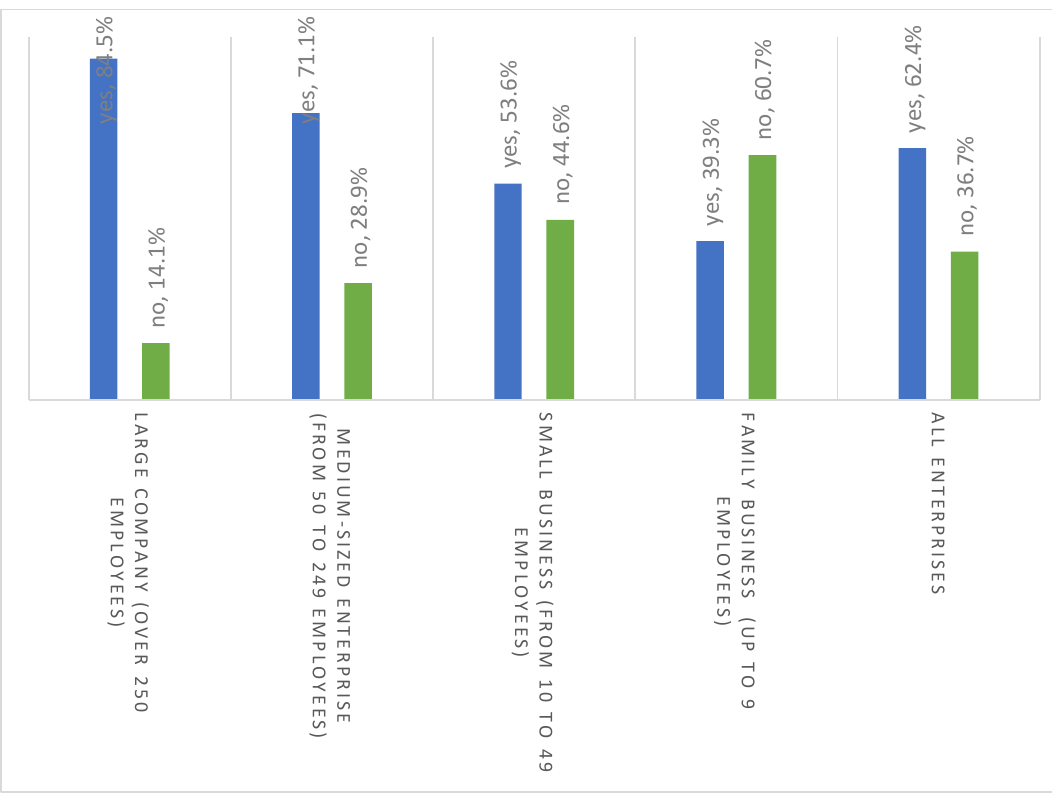
Figure 2. Industry 4.0 implementation rate in 2019.